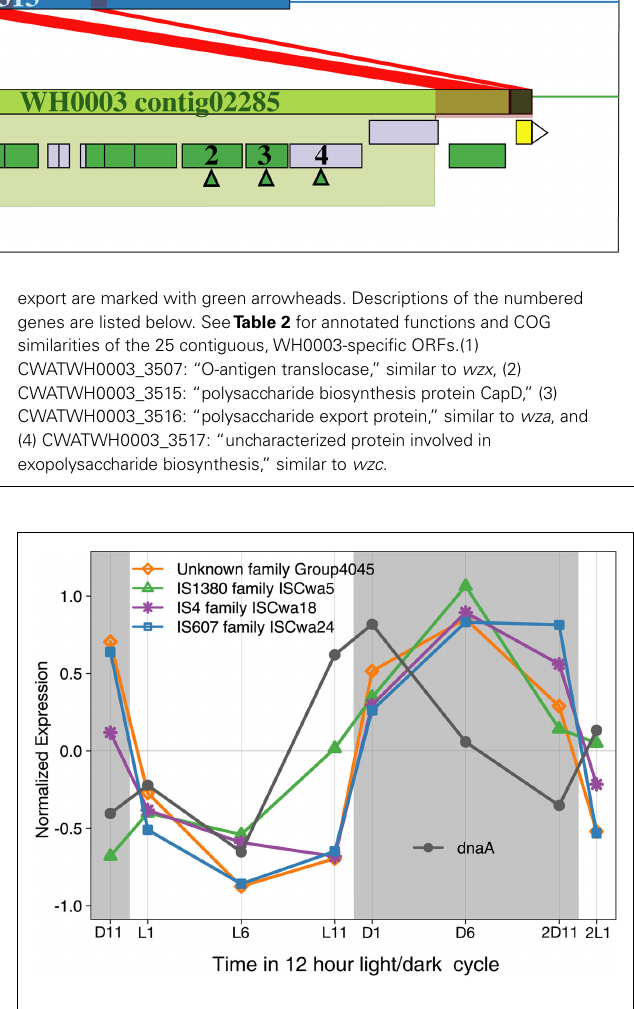
FIGURE 5 | Expression of four IS family genes and dnaA over 26h time period with a 12h light (L in white)/dark (D in gray) cycle. Expression values for each gene were normalized to average expression for that gene over the entire 26h time course, with negative expression values indicating down regulation, and positive values indicating up